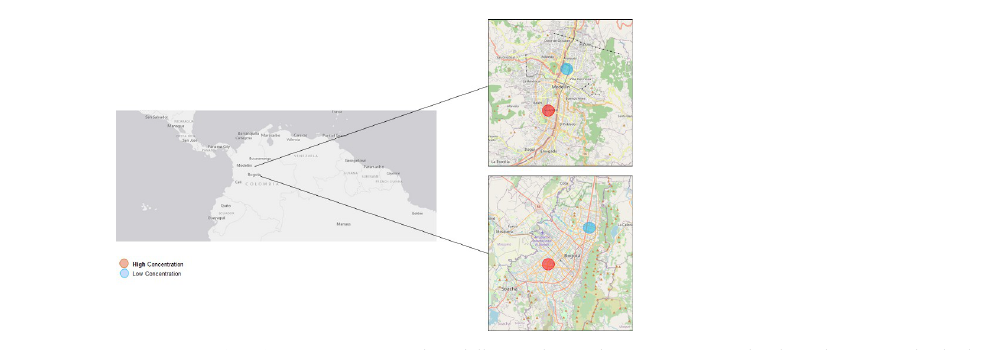
Fig 1. Map of study zones. Bogota and Medellin are the two biggest cities in Colombia. The zone with a high concentration of pollutants is indicated in red circle and the zone of low concentration in blue circle. Source: USGS National Map Viewer